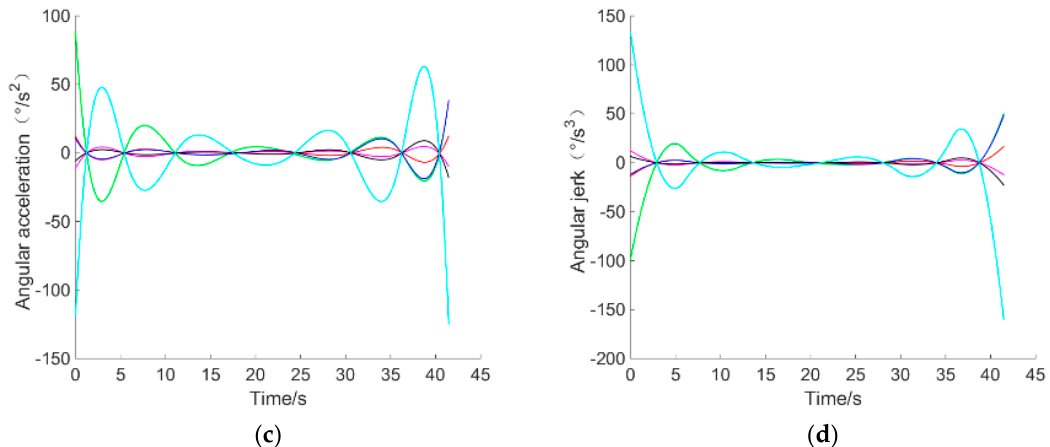
Figure 8. Energy-consumption optimal trajectory; ( a ) Position − Time chart of each joint; ( b ) Speed − Time chart of each joint speed; ( c ) Acceleration − time chart of each joint; ( d ) Jerk − time chart of each joint.